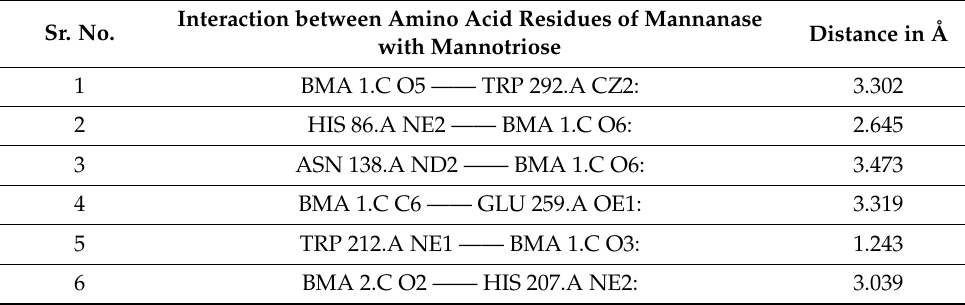
Table 3. Hydrogen-bonding interactions between mannanase with mannotriose. Sr.